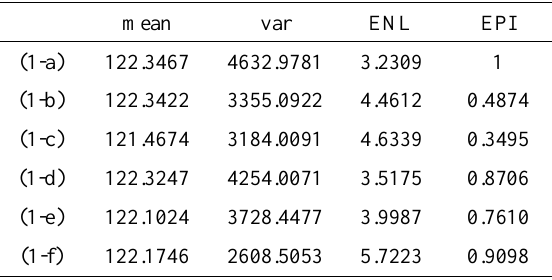
Figure 3. Three SAR images and filtered images